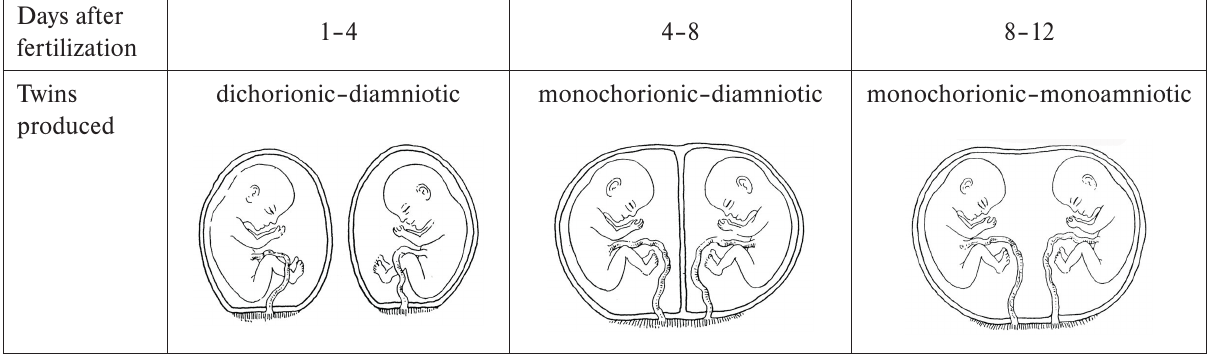
Fig. 1. Type of monozygotic twins depends on the time of